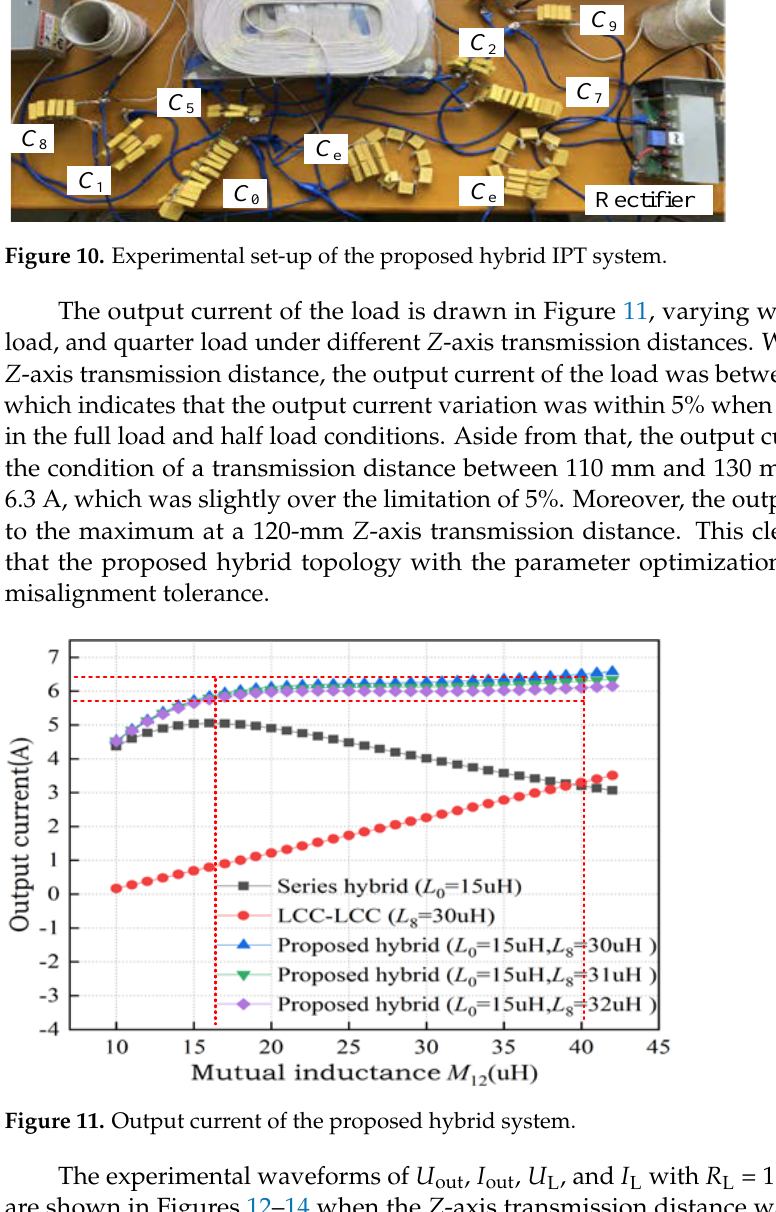
Figure 11. Output current of the proposed hybrid Figure 9. The function of I L and M 12 in Z -axis transmission distance.